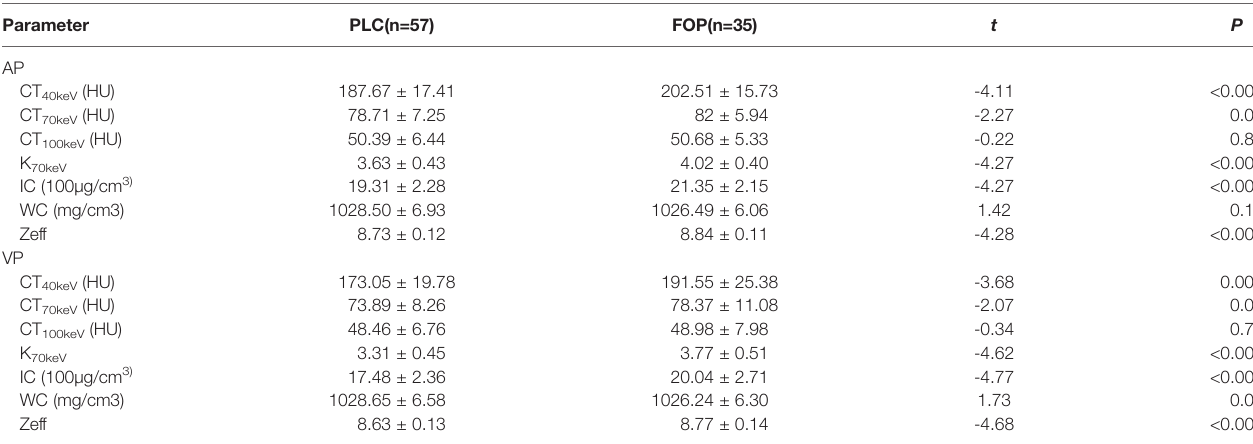
TABLE 2 | Comparison of spectral quantitative parameters of PCL and FOP in AP and VP.